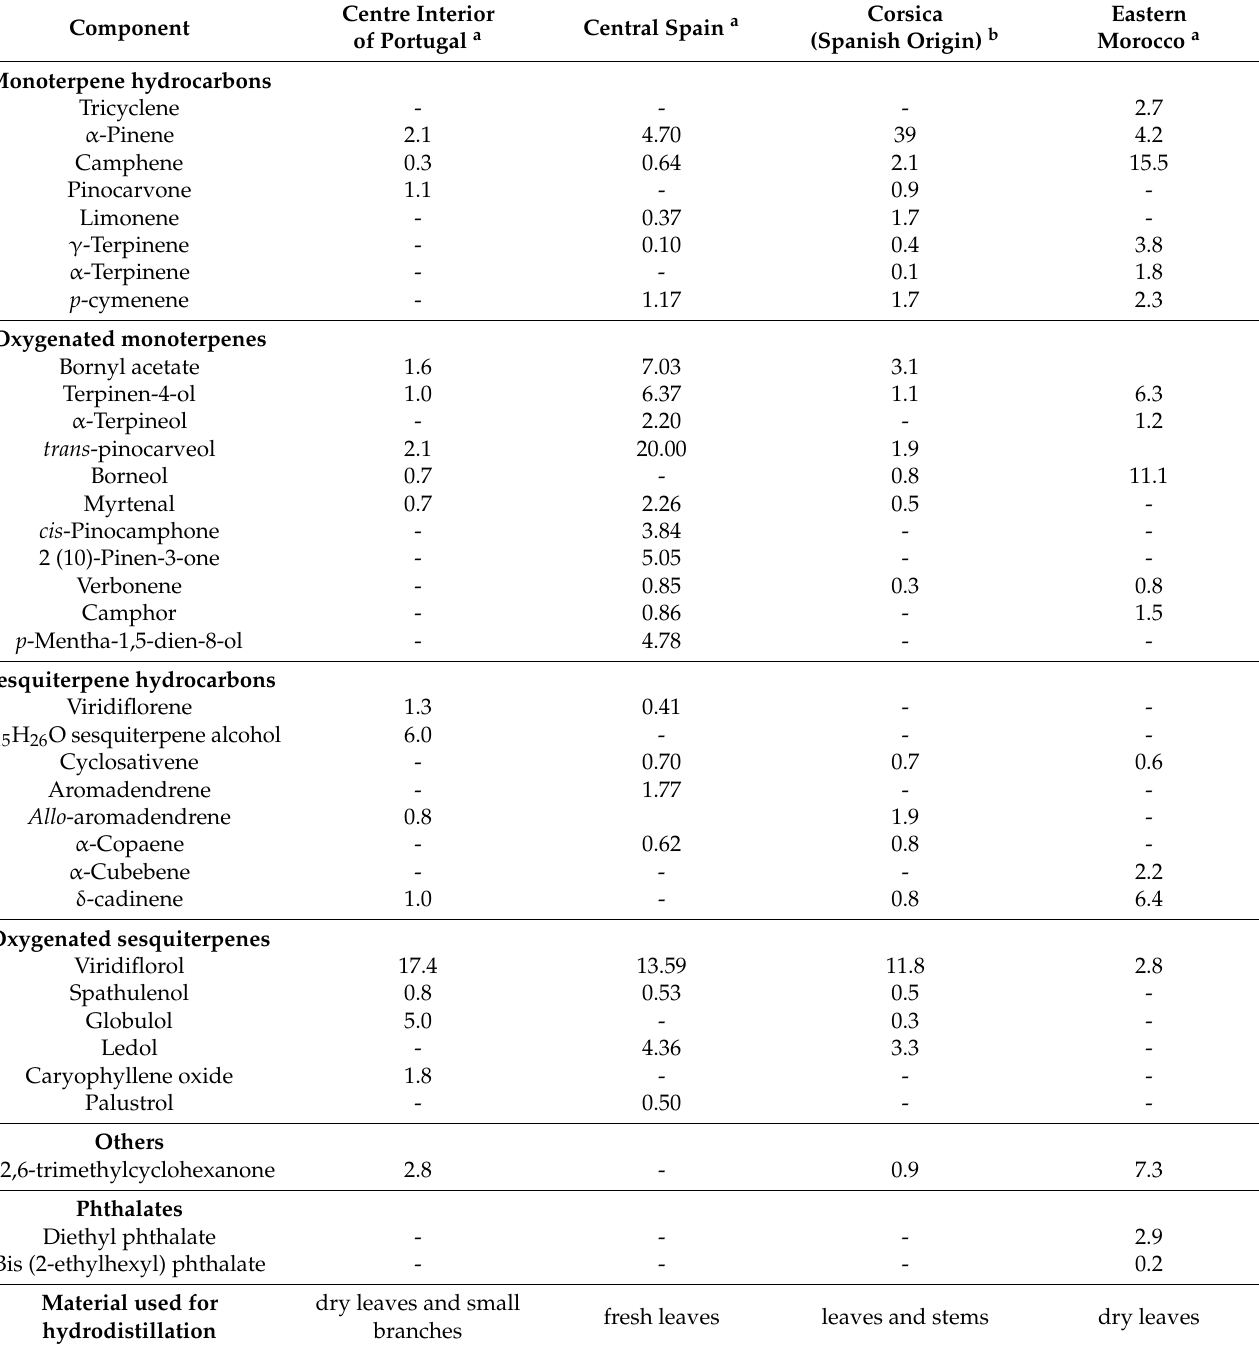
Table 1. Chemical composition (relative % of the peak area) of C. ladanifer essential oils from plants grown in different countries: center-interior of Portugal [29], central Spain [52], Corsica with plants of Spanish origin [55], and eastern Morocco